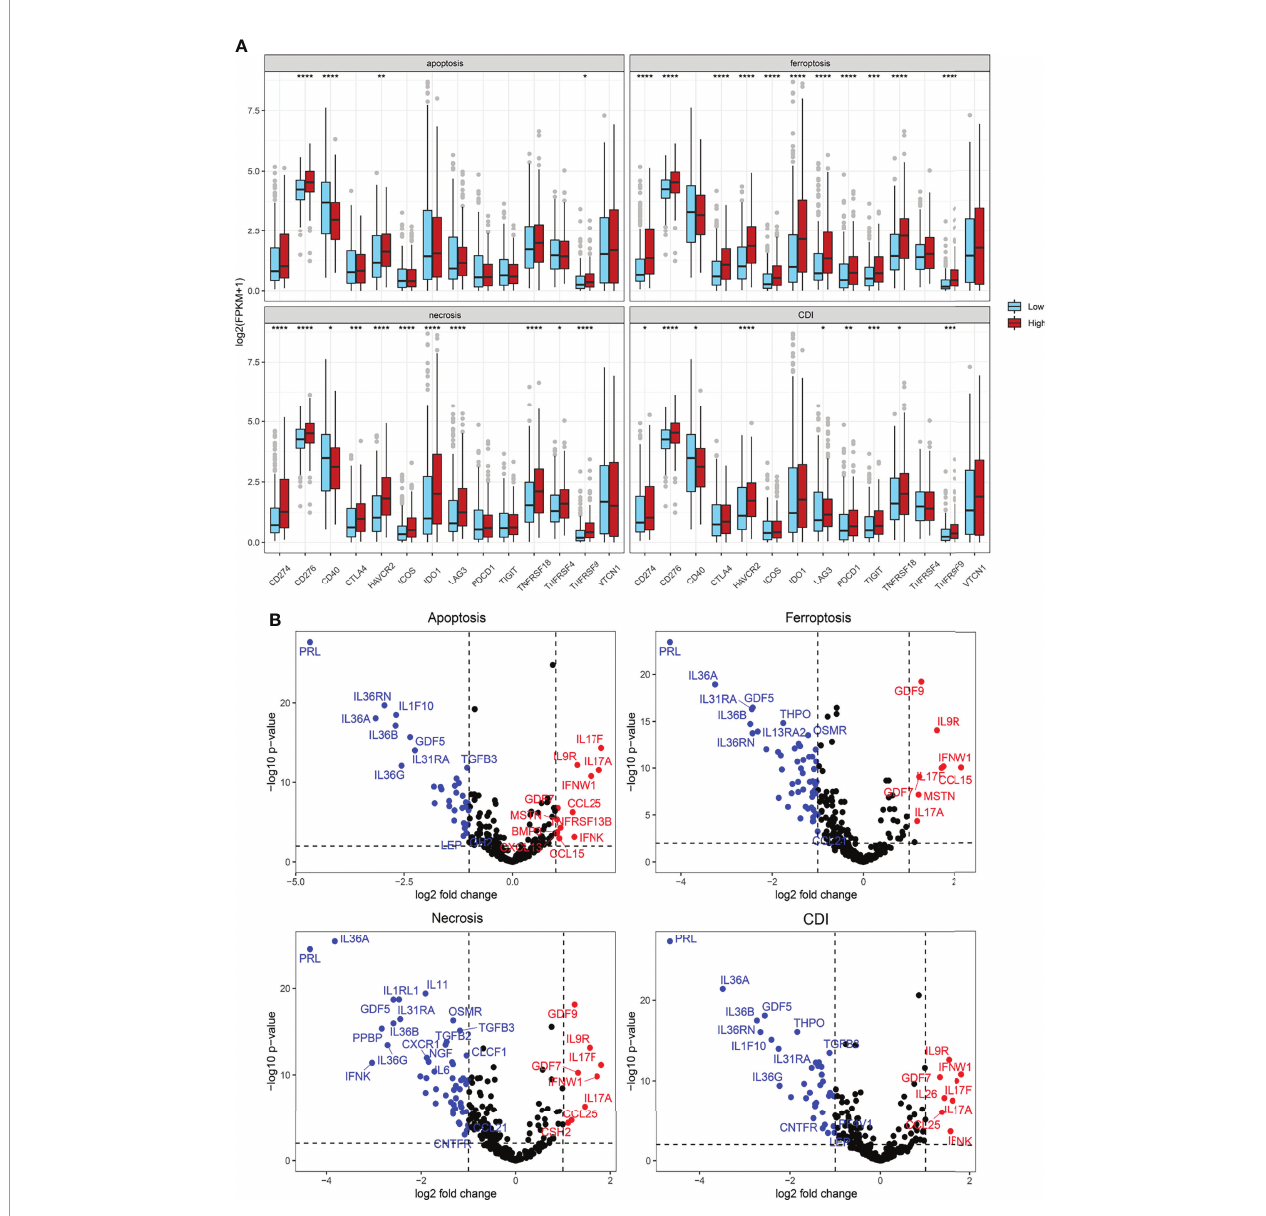
FIGURE 8 | Cytokine, immune suppression, and T-cell exhaustion markers. (A) Comparison of immune checkpoint and T-cell exhaustion marker expression levels using Student ’ s t-test. (B) Volcano plot showing signi fi cantly expressed cytokines using the “ Limma ” R package. * P < 0.05; ** P < 0.01; *** P < 0.001; **** P <